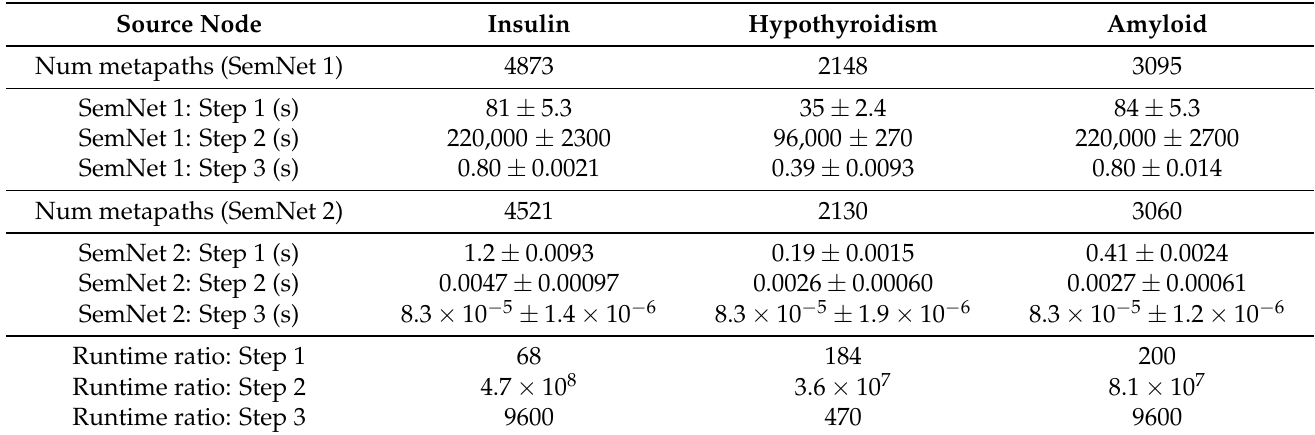
Table 2. Mean and standard deviation of runtimes for both SemNet version 1 and the approximate mean HeteSim algorithm from SemNet version 2, broken down by step as in Figure 5.